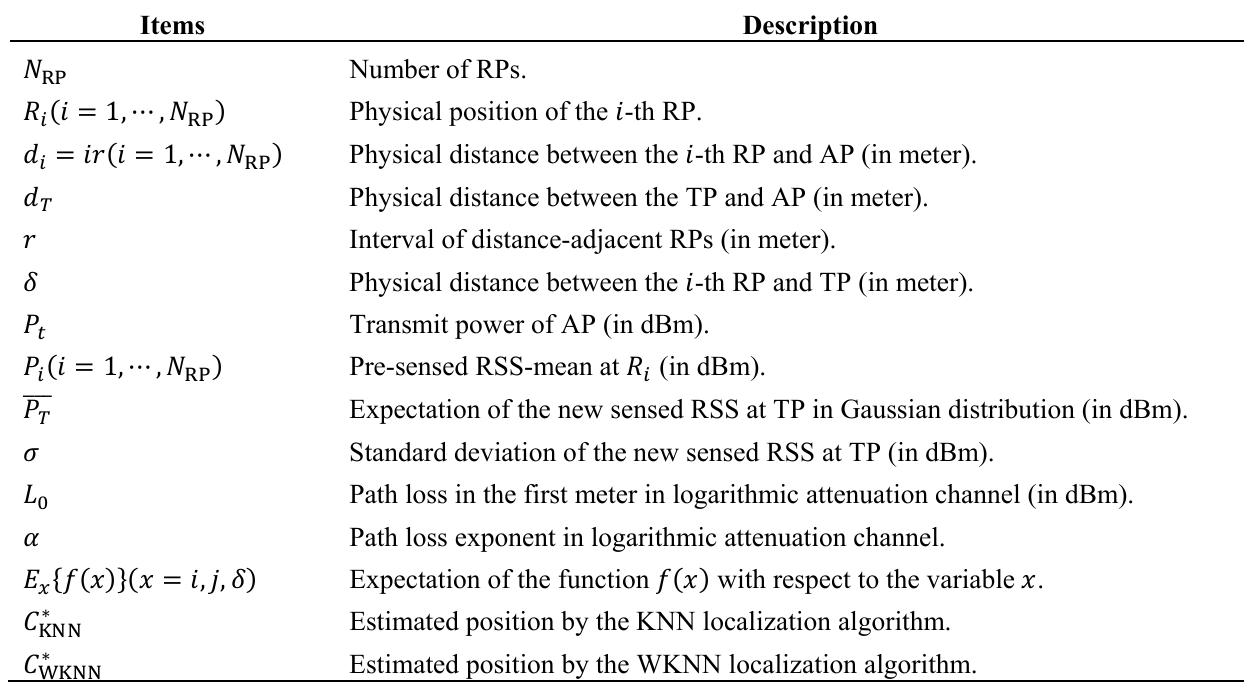
Table 1. Notations and